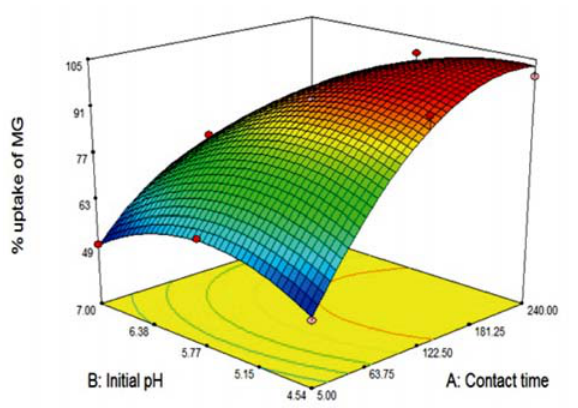
Figure 16. 3D surface plot of MG as a function of initial pH and contact time